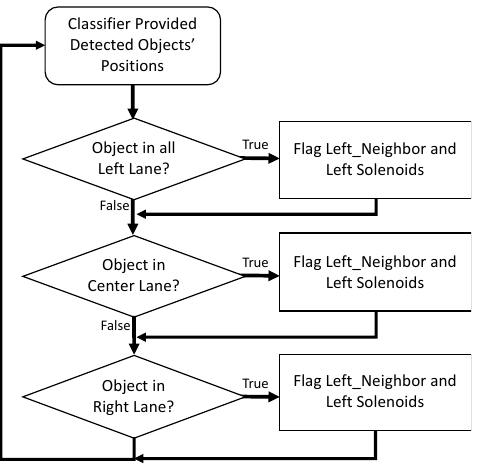
Figure 15. The flow chart for the solenoid firing loop.